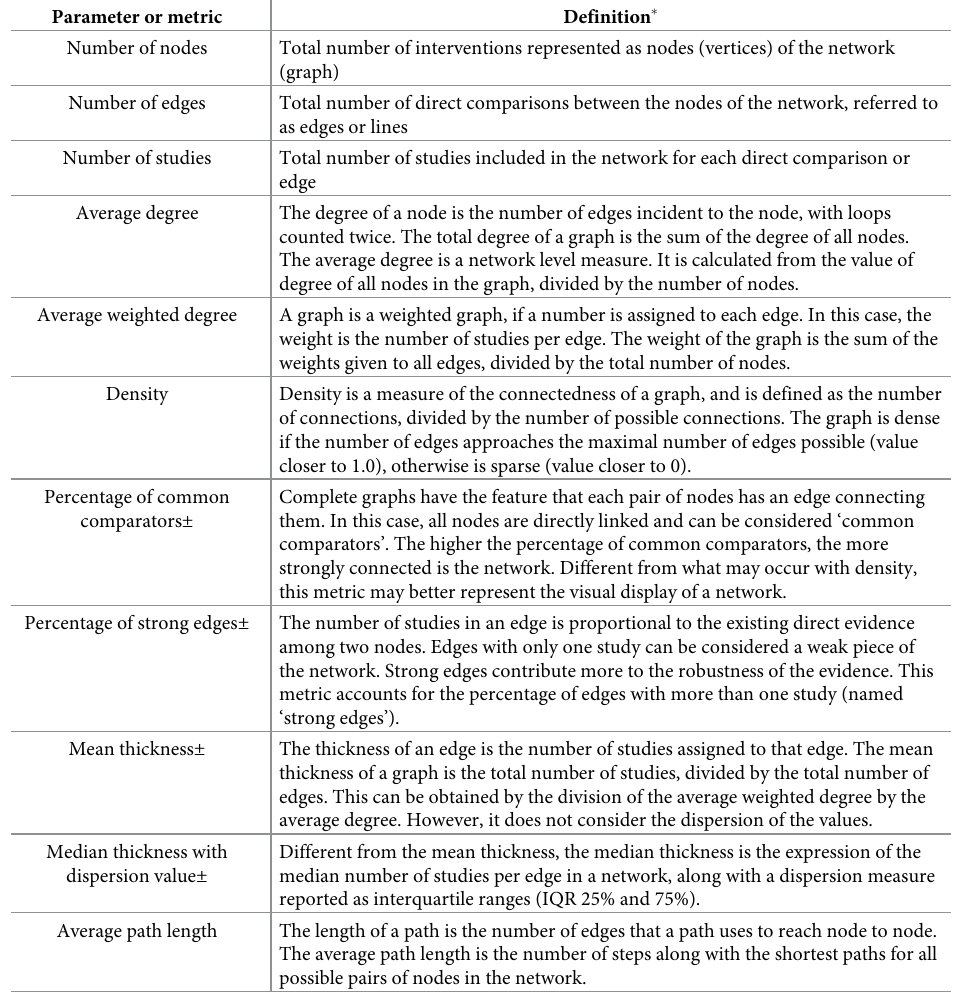
Table 1. Metrics